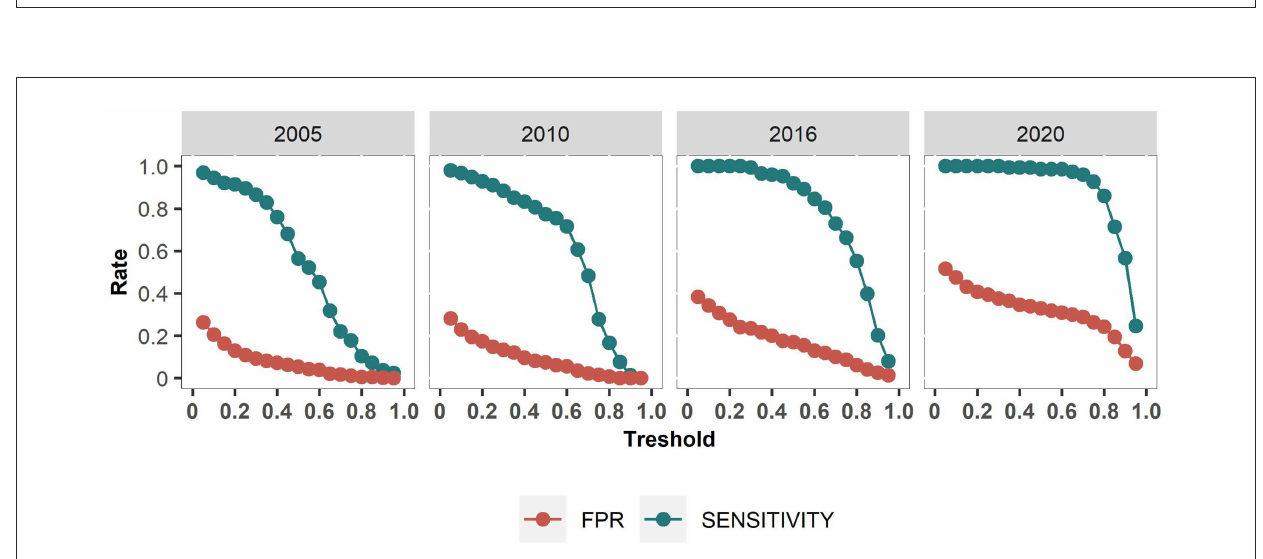
FIGURE5 Threshold analysis of maximum entropy models for fire occurrence in 2005, 2010, 2016, and